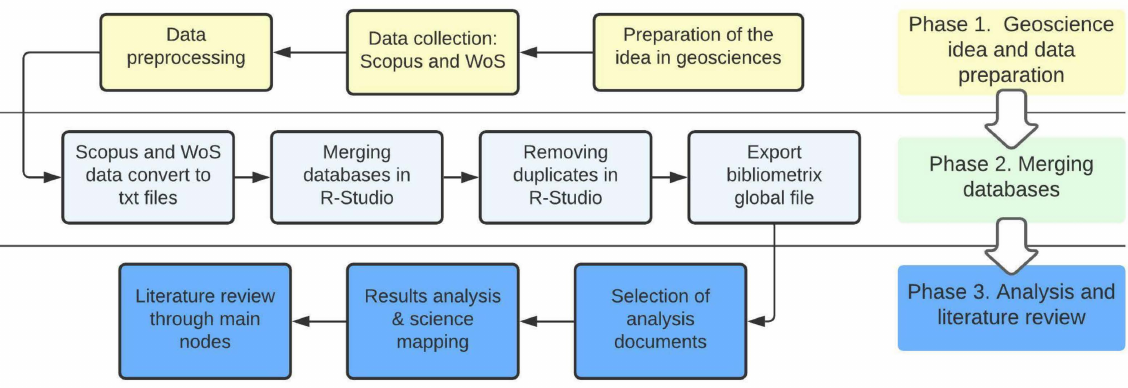
Figure 1. Diagram of the method used in this work. Based on the Echchakoui process for merging databases